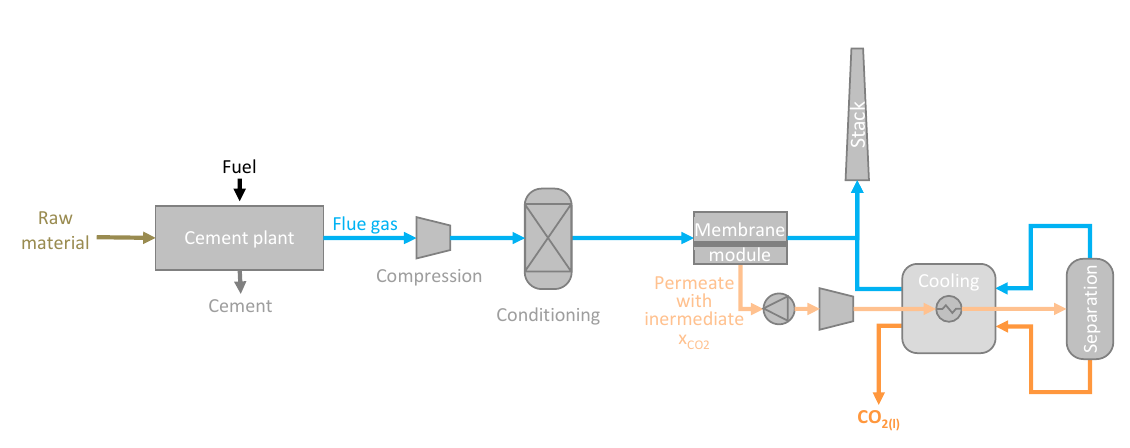
Figure 8. MAL system integrated in a cement plant (adapted from [53]).